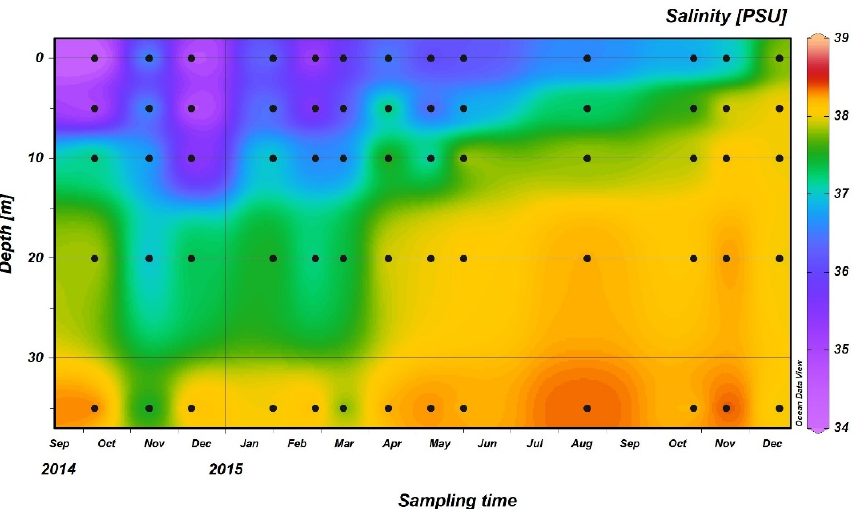
Figure 4. Vertical salinity profiles at station ST101 between October 2014 and December 2015. Γ − 30.0 to 138 pg L − 1 m − 1 . As seen from Figure 0-5 in surface seawater ranges from